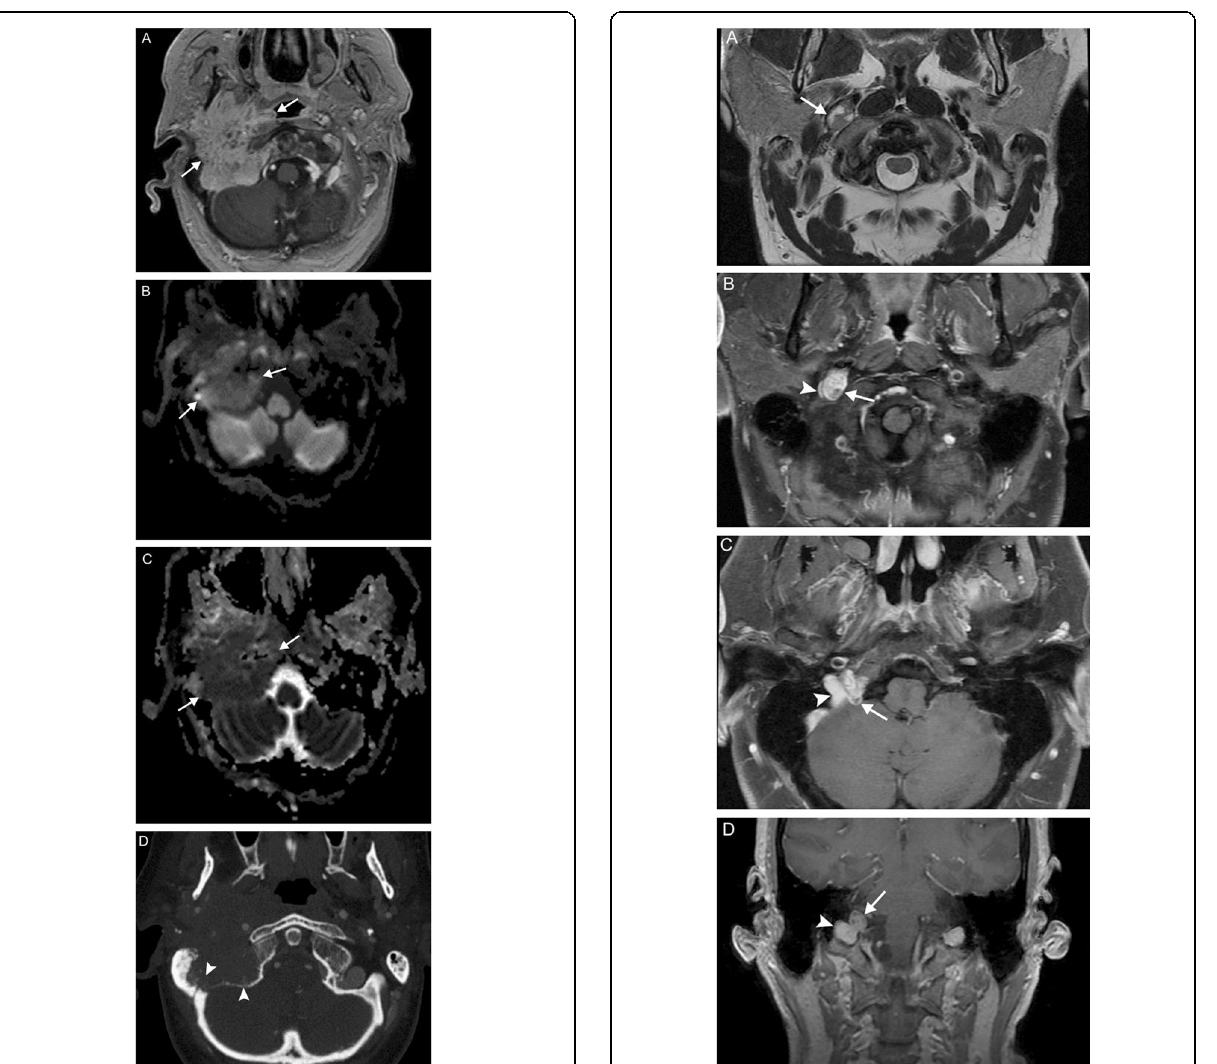
Fig. 16 Skull base metastasis. A 63-year-old woman with several weeks of right-sided ear infection and hoarseness, followed by sudden onset right facial droop. Axial post-contrast T1-weighted ( a ) and DWI/ADC ( b , c ) MR images reveal a large enhancing infiltrative lesion with diffusion restriction at the skull base (arrows). Axial CTA image ( d ) demonstrates osseous destruction and obliteration of the right internal jugular vein (arrowheads). This was found to be metastatic adenocarcinoma of unknown primary